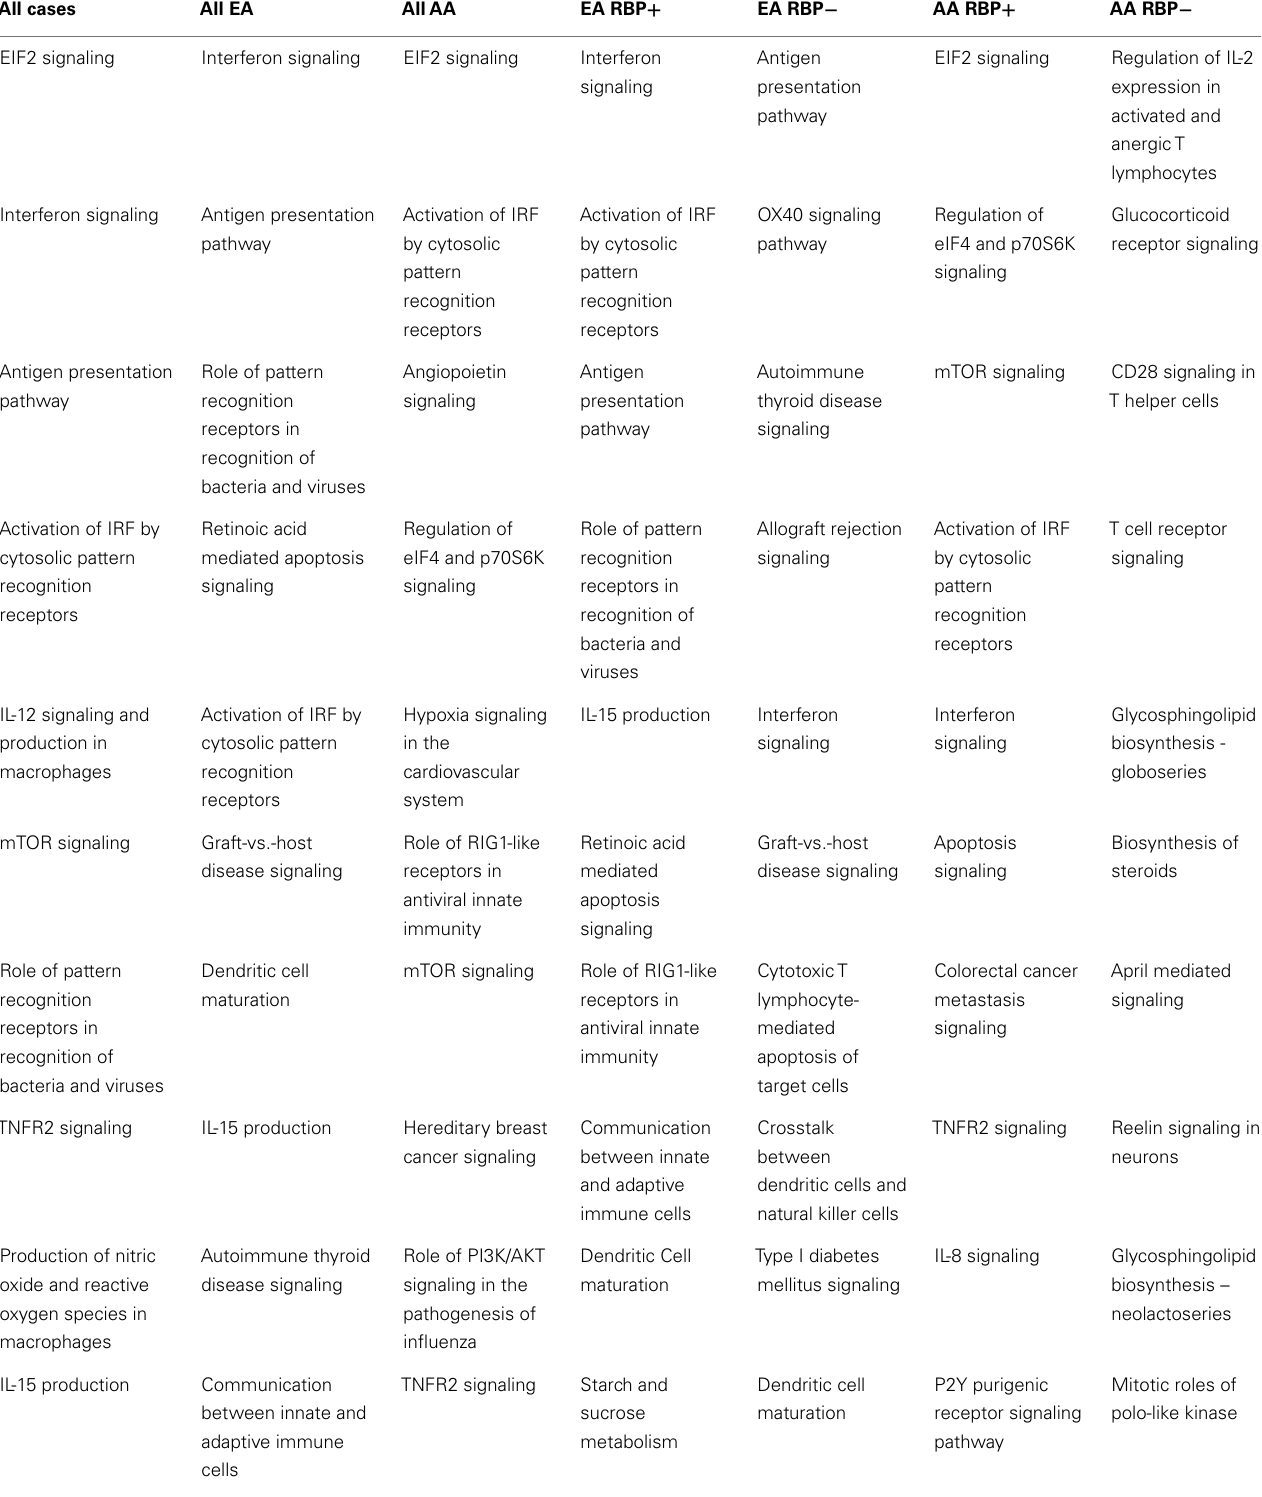
Table 2 |Top 10 canonical pathways from each subgroup vs. matching controls through IPA from microarray